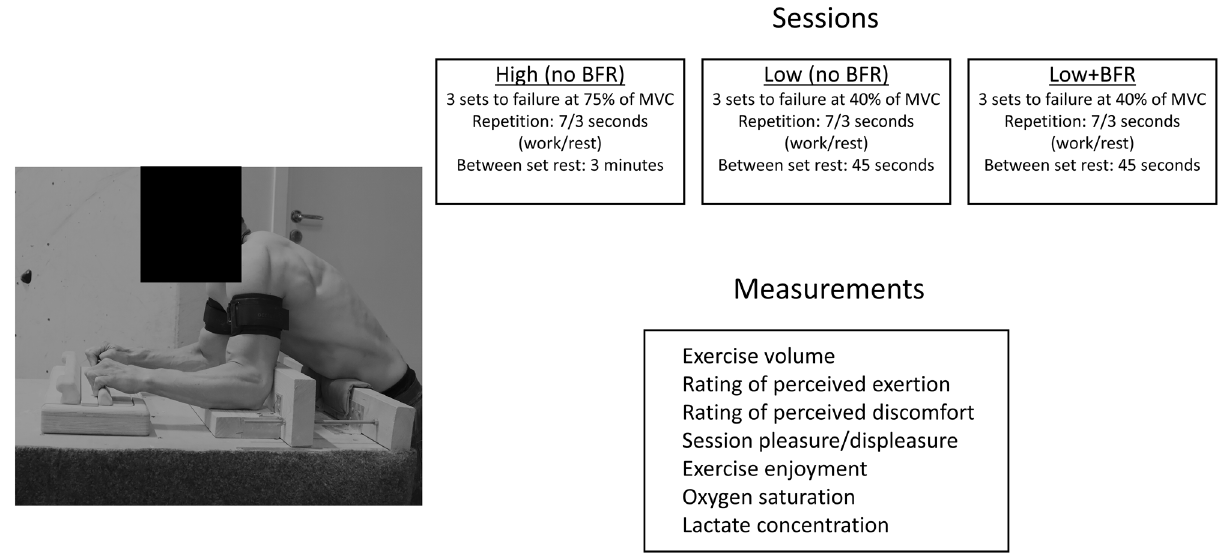
Figure 2. Overview of the study design and finger flexor training